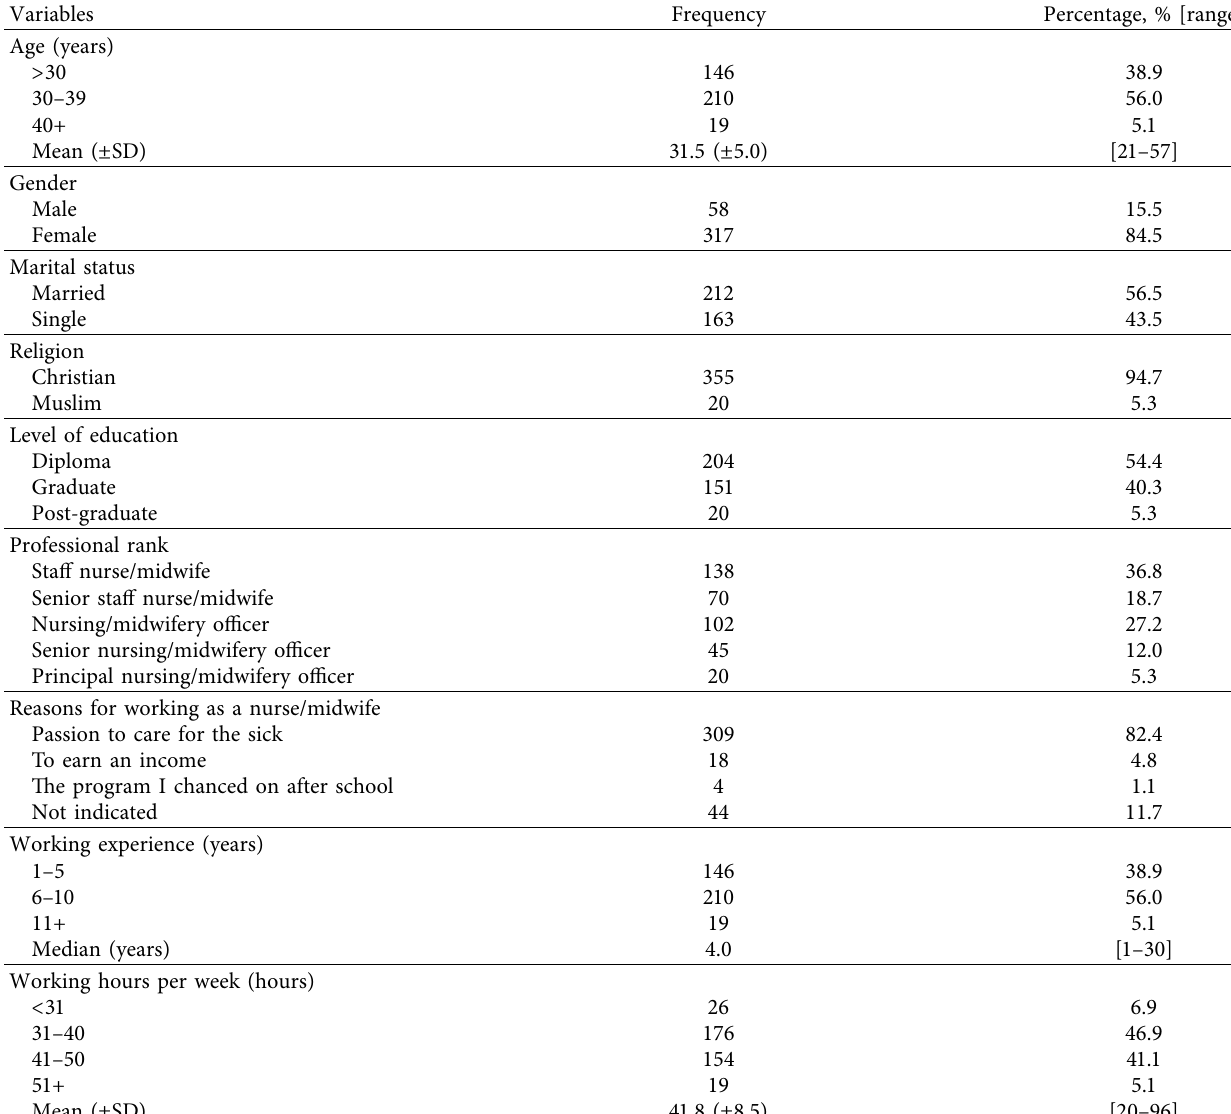
Table 1: Demographic and work-related characteristics of study